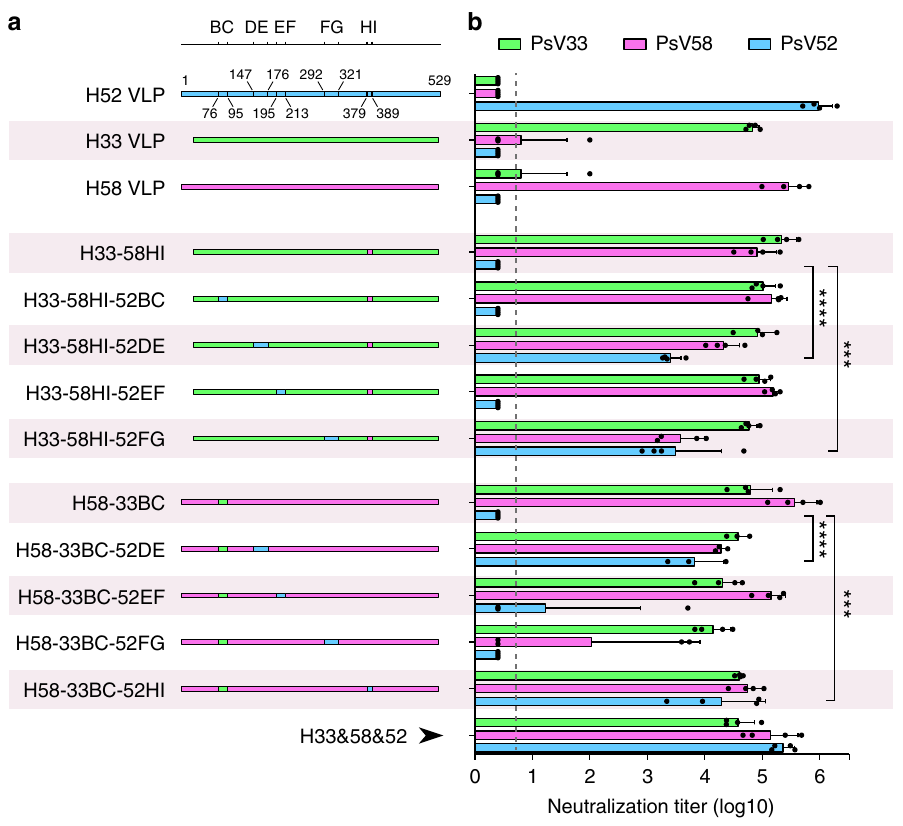
Fig. 4 Immunogenicity of loop-swapped HPV33/58/52 chimeric VLPs. a Schematic representation of the chimeric HPV33/52/58 L1 proteins based on chimeric L1 proteins H33-58HI and H58-33BC. A group of mice were immunized with mixed WT HPV33, -52 and -58 VLPs. b Neutralization titers of the immune sera from BALB/c mice ( n = 4) collected 4 weeks after the third immunization (immunization at weeks 0, 2 and 4 with 5 μ g per dose of aluminum adjuvant-containing tripe-type chimeric or WT VLPs). All the data were analyzed by one-way ANOVA, ** P < 0.01; *** P < 0.001; **** P < 0.0001. The error bars are standard deviation and symbols represent individual mice. The dotted line indicates the limit of detection for the assay. Non-neutralizing sera were assigned a value of one-half of the limit of detection for